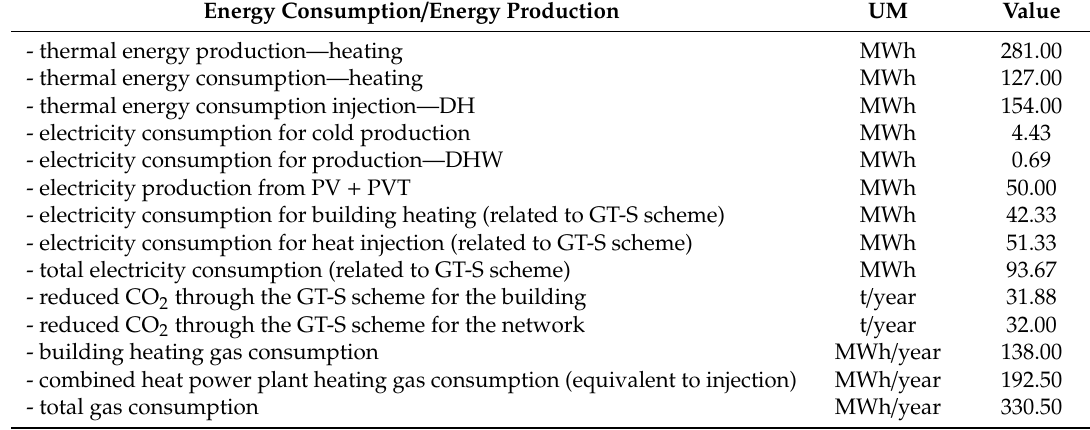
Table 1. Consumption of thermal and electrical energy of target building and the productions related to the hybrid